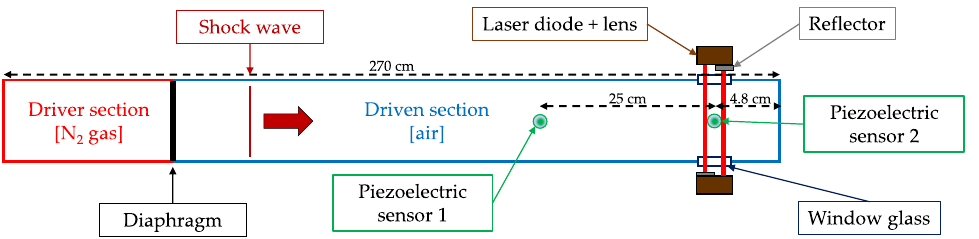
Figure 1. Schematic illustration of optical sensor implementation on the shock tube at a CEA Facility. The two SMI systems are facing each other. Two reference sensors measure the pressure in two different